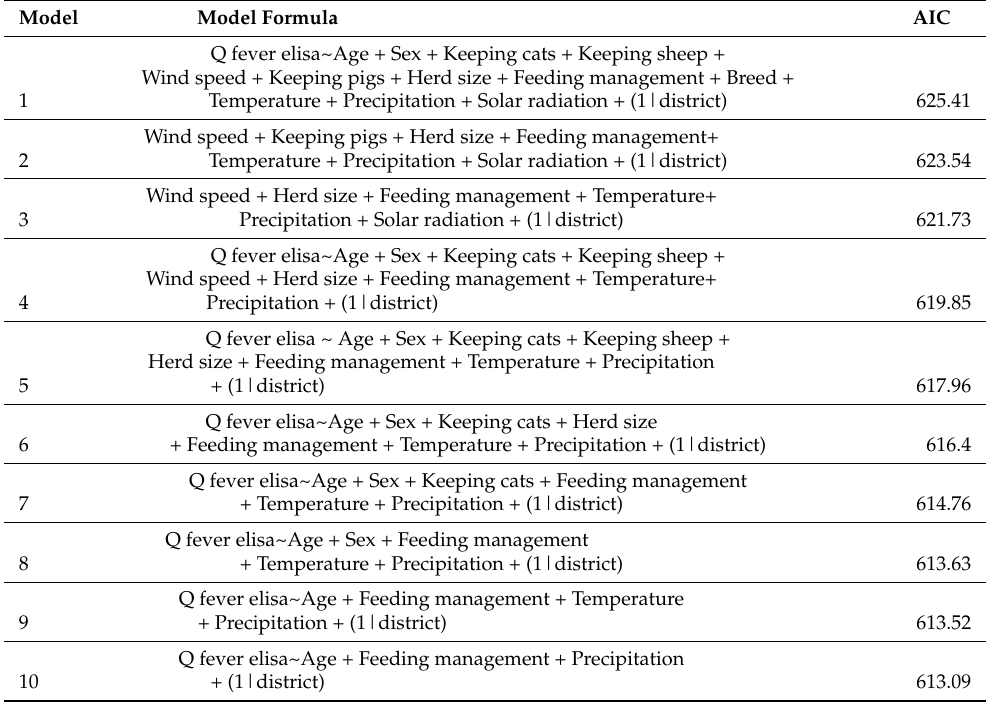
Table 3. Comparison of mixed-effects logistic regression risk factor models for Q fever seropositivity. For each model, the model formula with their Akaike Information Criterion (AIC) values are